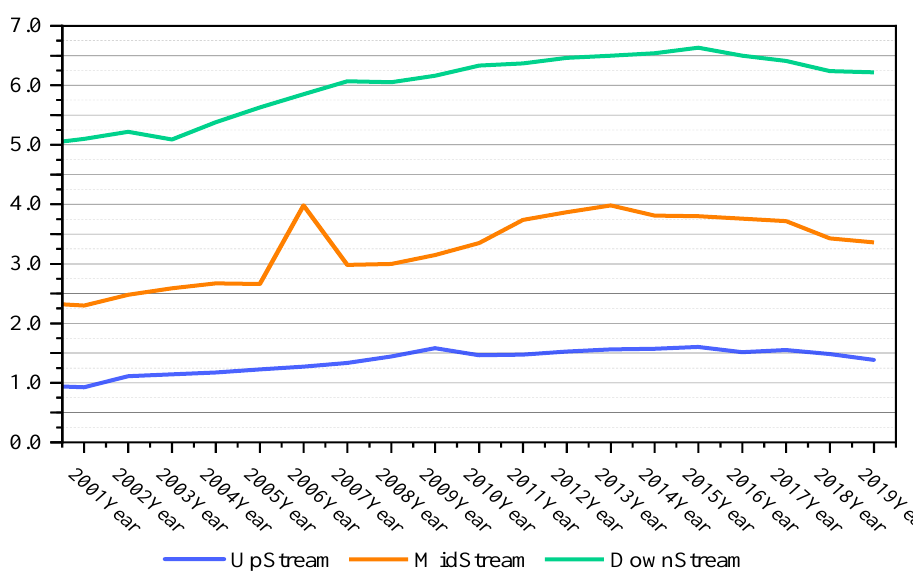
Figure 3. AWF grey in the Upper, middle and lower Reaches of the Yellow River Basin from 2000 Figure 3. 𝐴𝑊𝐹 𝑔𝑟𝑒𝑦 in the Upper, middle and lower Reaches of the Yellow River Basin from 2000 to 2019. to